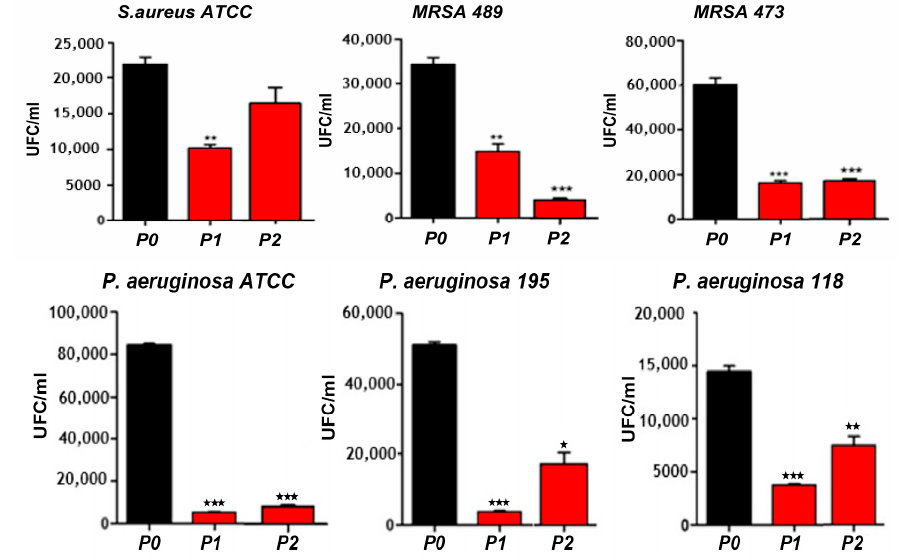
Figure 7. Bacterial population in colony forming unit (UFC/mL) of different S. aureus strains and P. aeruginosa strains adhered on P0, PI and P2 films. *, ** and *** correspond to the magnitude of antimicrobial activity. MRSA: Methicillin-resistant Staphylococcus aureus, and ATCC: American Type Culture Collection.